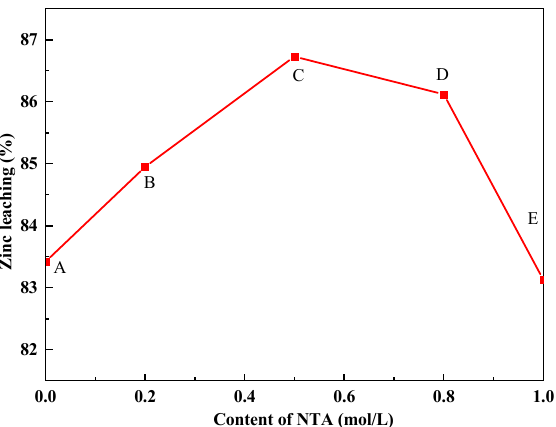
Figure 11. The effect of NTA 3 − concentrations on the leaching of complex zinc ore.